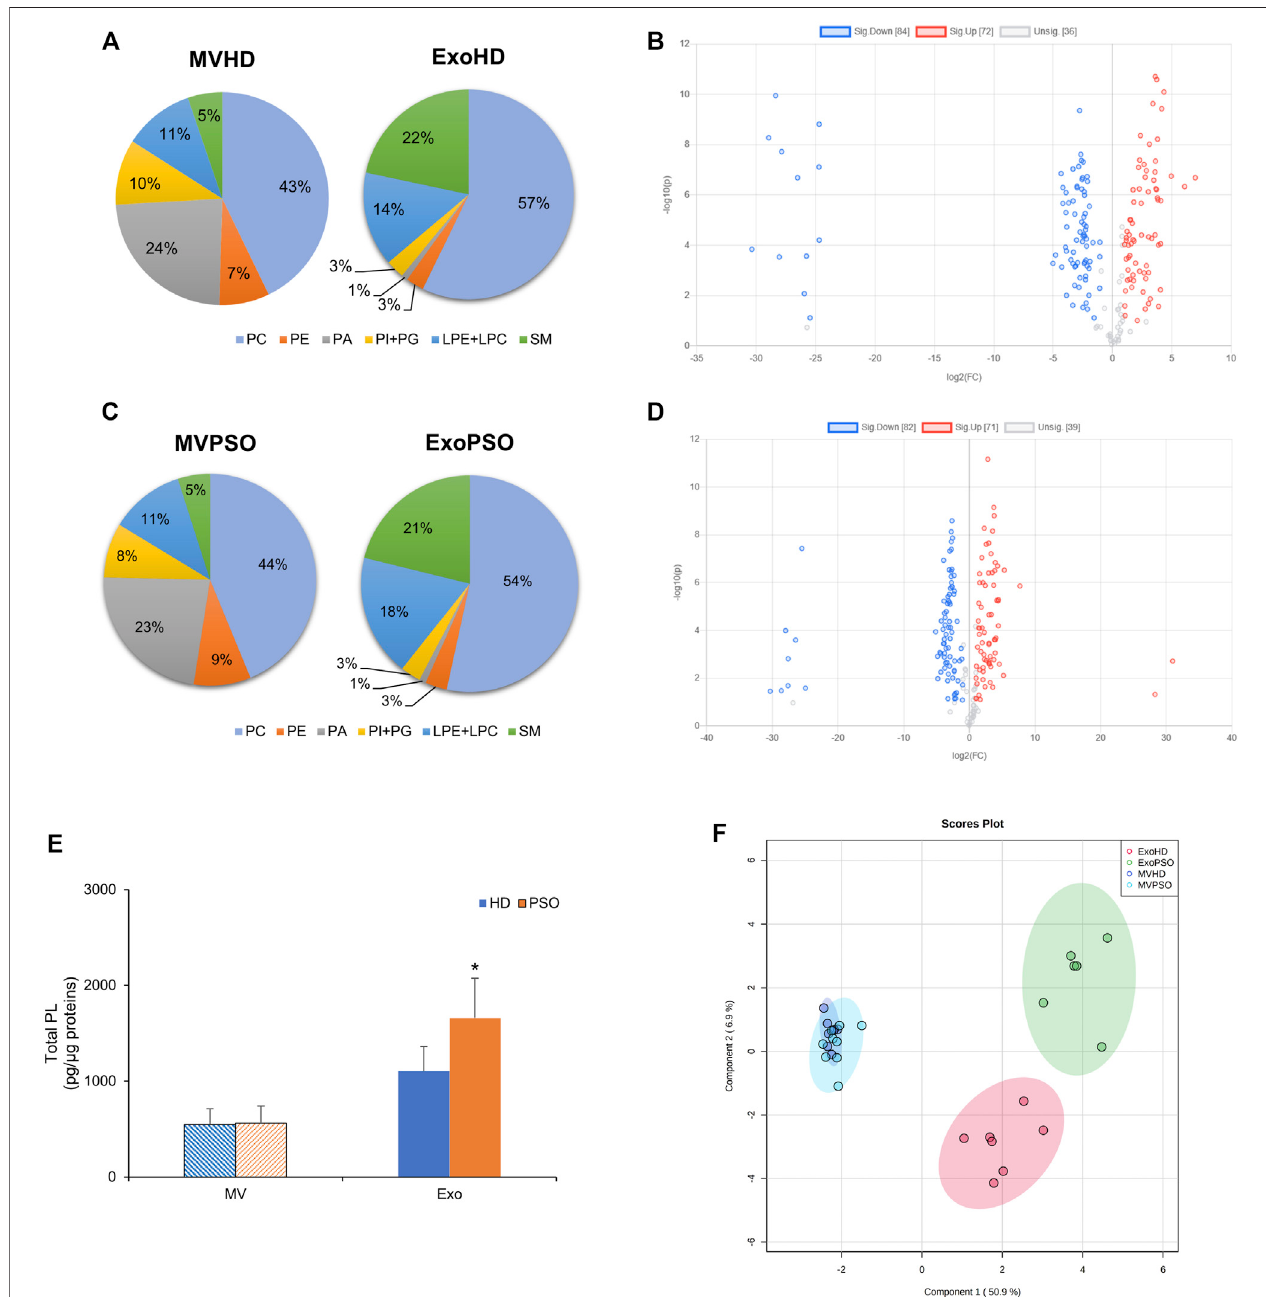
FIGURE 2 | Statistical analysis of phospholipids detected in EVs from HD and PSO. (A) Pie charts of the percentage of each phospholipid class in MVHD and ExoHD. (B) Volcano plot of individual lipid species in MVHD and ExoHD. Lipids in blue and red were increased and decreased in MVHD vs. ExoHD, respectively (FC > 2 and p -value < 0.1). (C) Pie charts of the percentage of each phospholipid class in MVPSO and ExoPSO. (D) Volcano plot of individual lipid species in MVPSO and ExoPSO. Lipids in blue and red were increased and decreased in MVHD vs. ExoHD, respectively (FC > 2 and p -value < 0.1). (E) Amount of phospholipids (PL) relative to protein content. Data are reported as mean ± S.D. (* p < 0.05, PSO vs. HD). (F) PLS-DA of lipid species from HD and PSO, both for MV and Exo. 95% ellipses are constructed on each of the four groups. The dataset was normalised by median and scaled by Pareto algorithm.